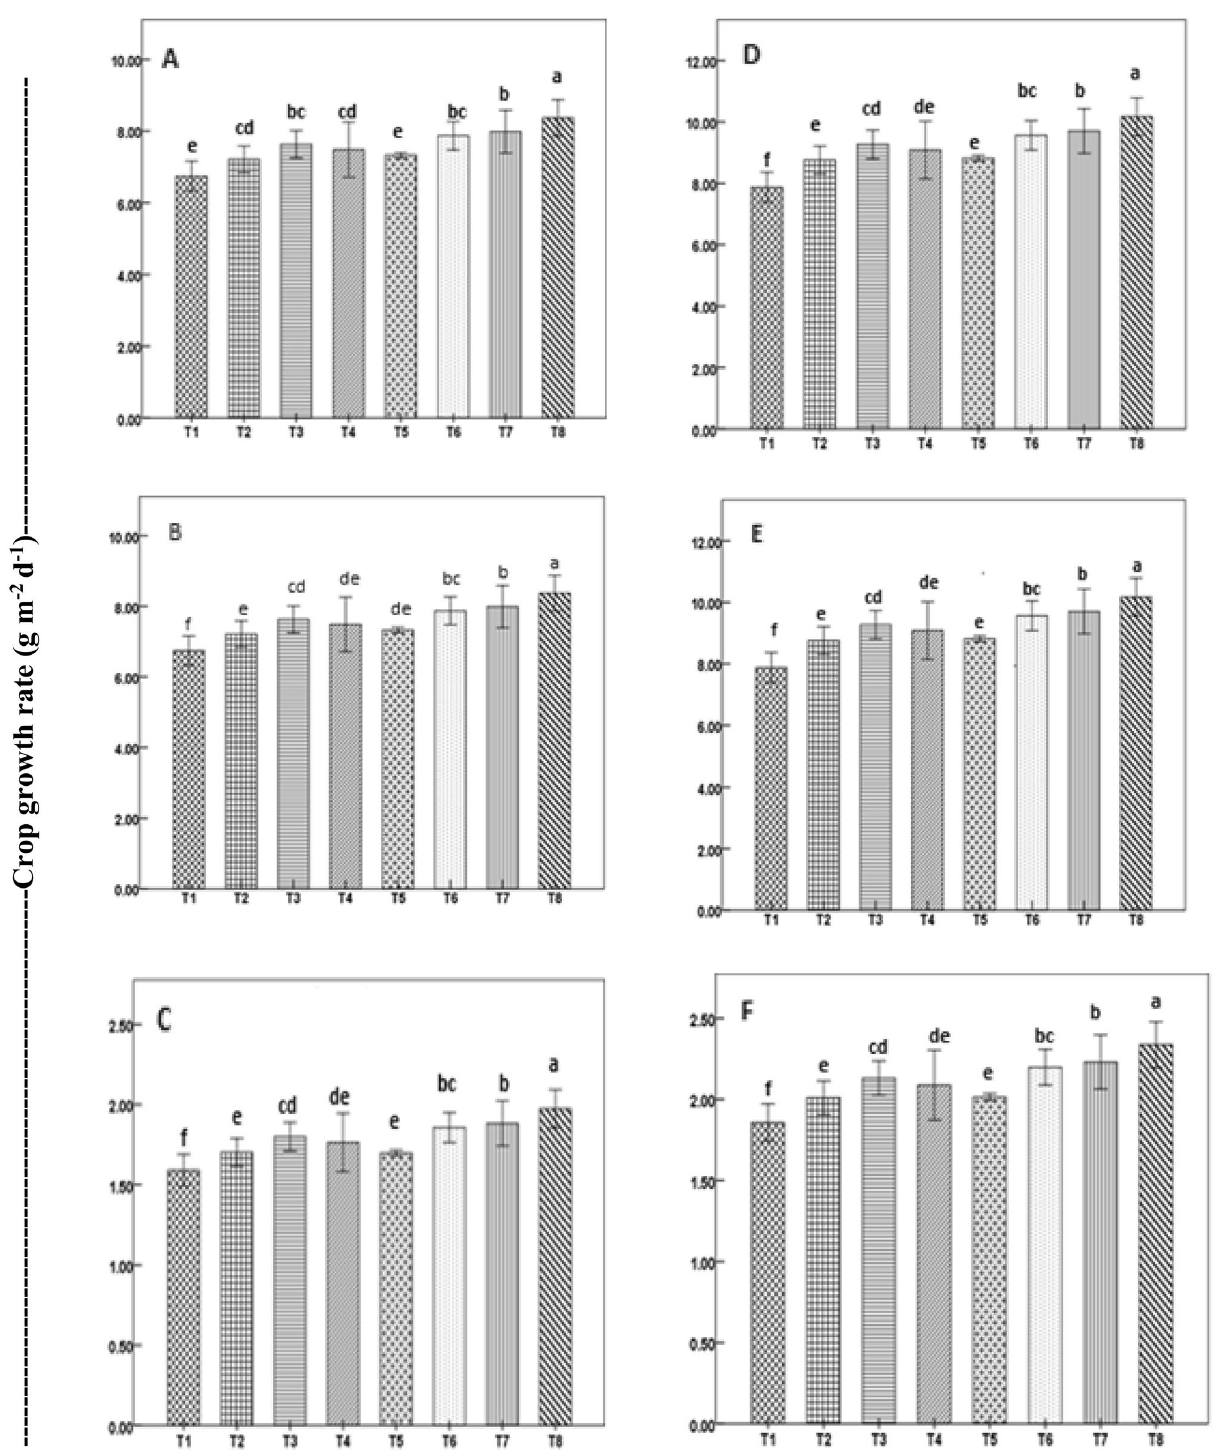
Figure 3. Crop growth rate of direct-seeded rice during vegetative ( A , D ), reproductive ( B , E ), and ripening ( C , F ) stages as affected by seed priming in a field experiment in 2019 ( A – C ) and 2020 ( D – F ). Treatment bars with different letters represent significant differences (P < 0.05) between means. Vertical lines with caps are ± standard error of the mean of treatments. Treatments details are given in Table